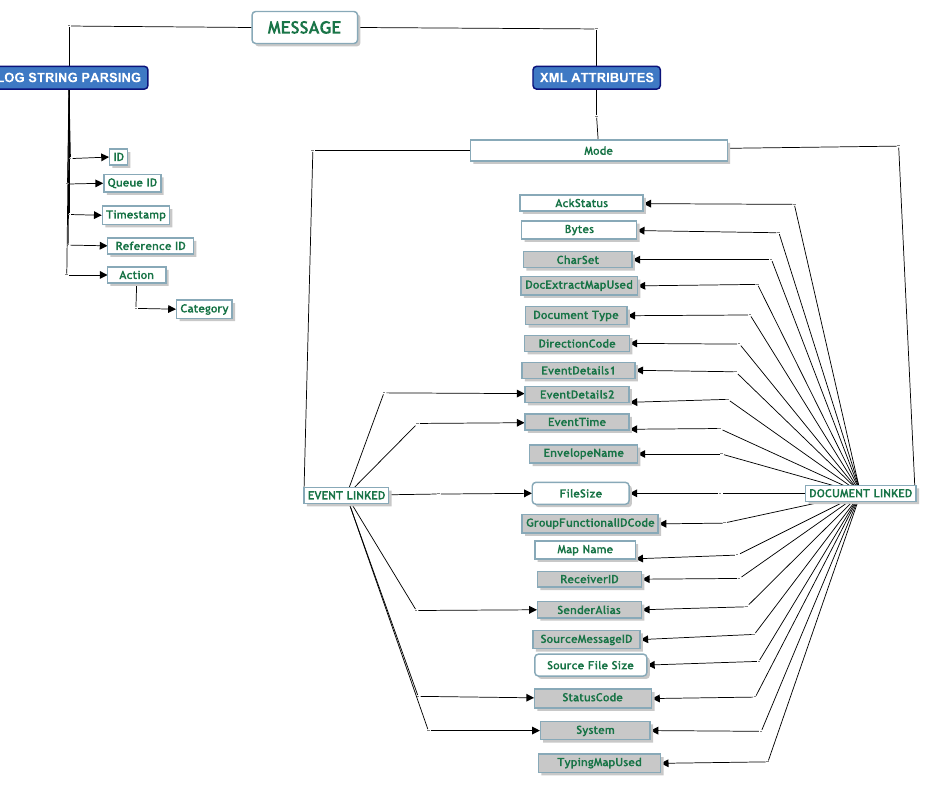
Figure 4. Message attribute